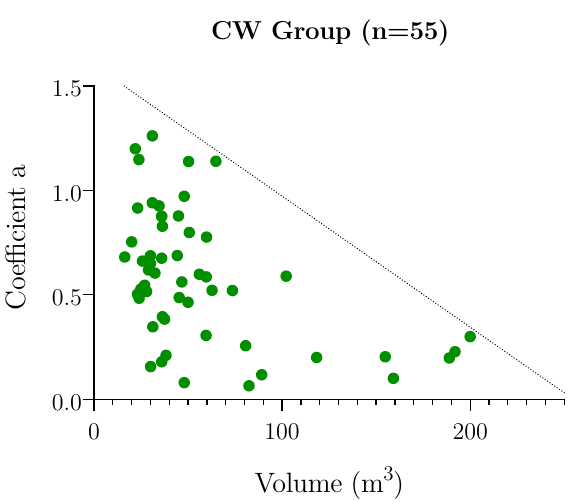
Figure 6. Value of the fitting coefficient a (green dots) estimated on the intensity-based model, for participants of the CW group as a function of the self-reported volume of the